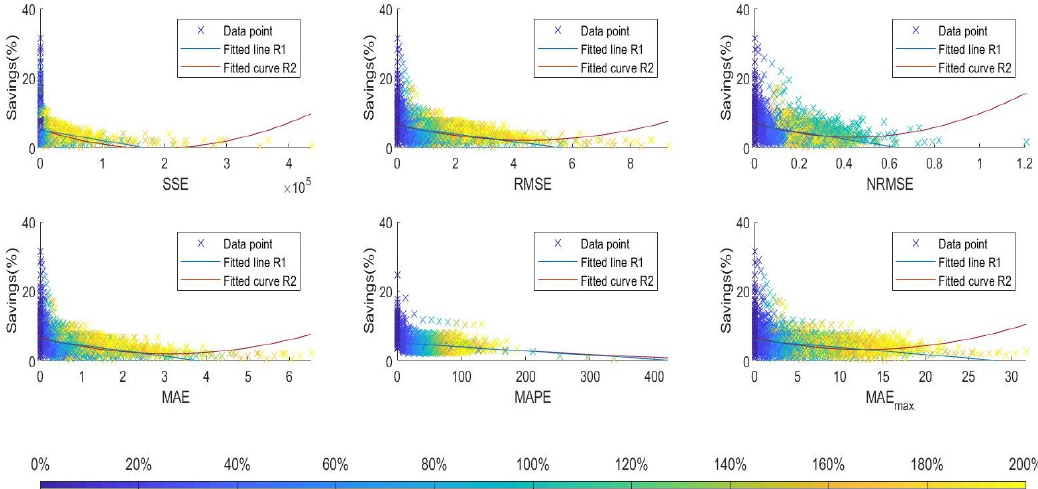
Figure 2. Percentage yearly savings of customers when using energy storage to decrease monthly maximum peak powers and the costs of market priced energy, shown as a function of different forecast error criteria. Color of points shows the used error level (0–200%).